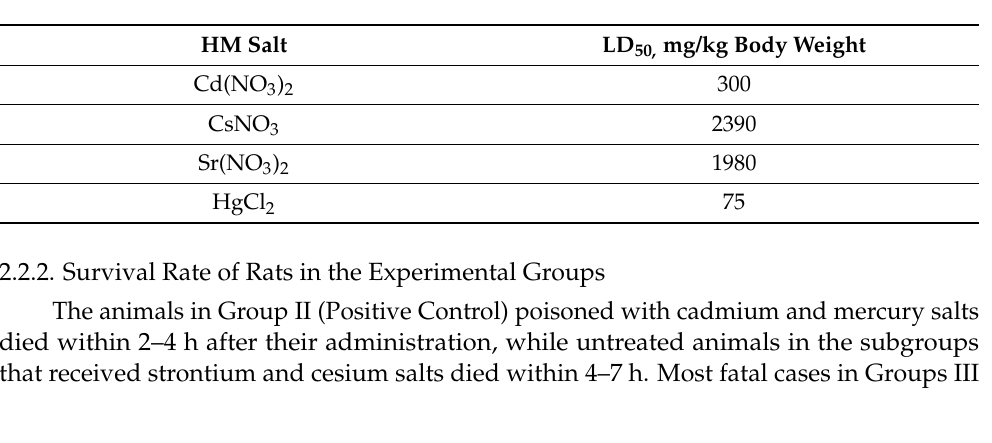
Table 1. An average lethal dose (LD 50 ) of various heavy metal salts administered orally in experi- mental